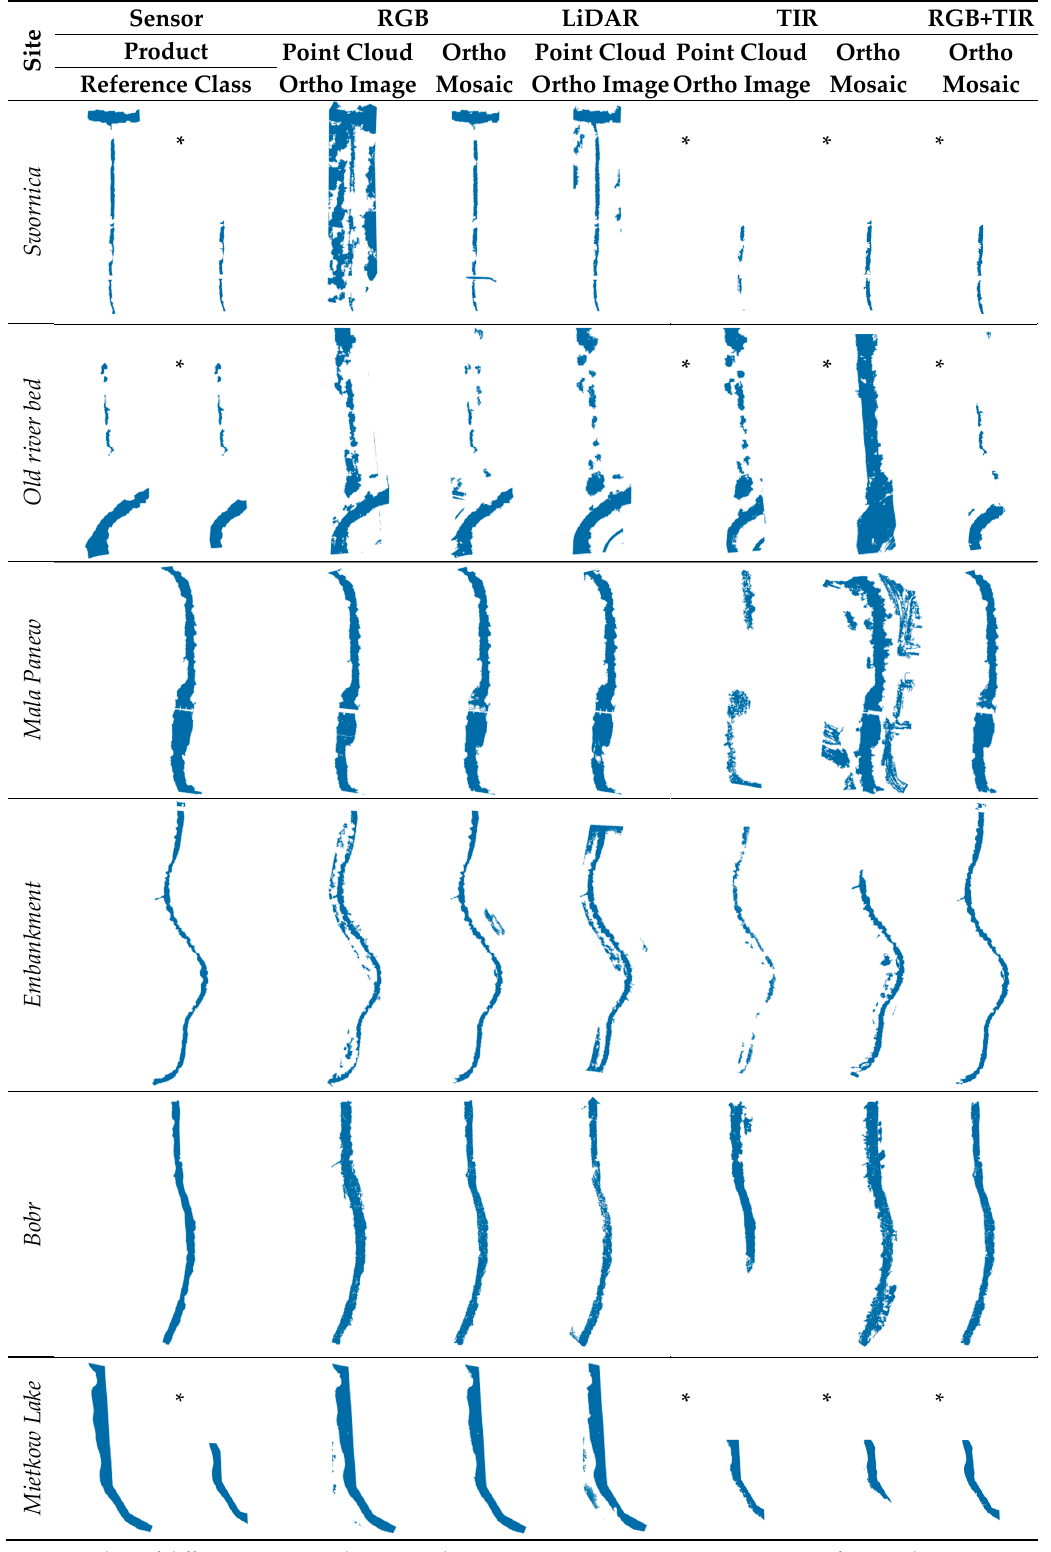
Table 5. The comparison of reference class Water with the classification results obtained for different sensor-products and test sites.